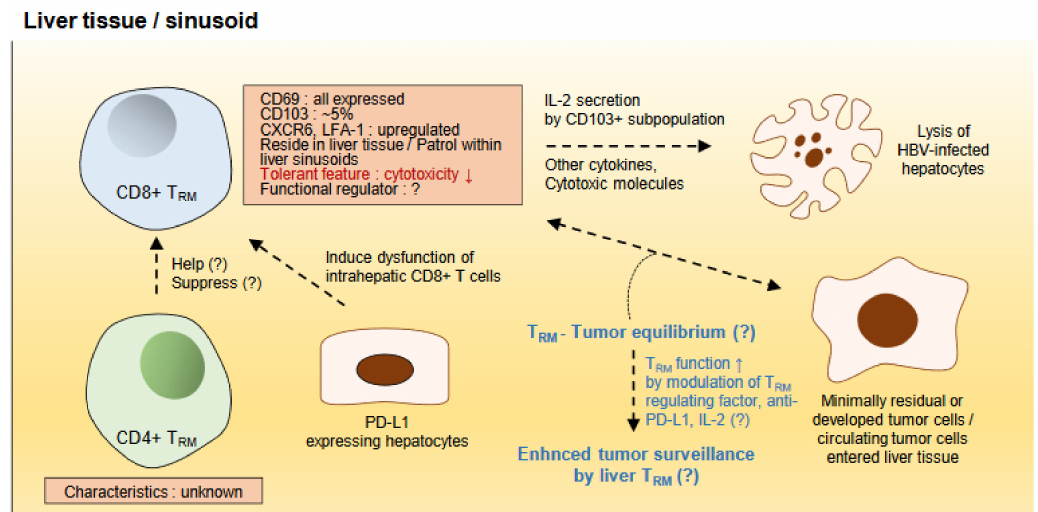
Figure 2. Suggestive model of tumor surveillance by liver T RM cells. The liver CD8+ T RM cells have been studied in several previous reports. They express CD69, but CD103 is expressed in the small portion among the CD69+ population in human. They express chemokine receptor type 6 (CXCR6) and lymphocyte function-associated antigen-1 (LFA-1) and persist in the liver tissue or liver sinusoid. Although their regulating factor is still unknown, liver CD8+ T RM cells are considered to be functionally impaired or tolerant compared with the other T cell population. This might be associated with the priming by PD-L1-expressing hepatocytes. The CD103+ subpopulation is known to perform an anti-viral function, because they can highly secrete IL-2 and other effector molecules against hepatitis B virus (HBV) peptide stimulation. However, the characteristics of CD4+ T RM cells and their role in the tumor surveillance are still unknown. T RM -tumor equilibrium (left-right arrow) has not been studied in the HCC model, but as in other cancers, liver CD8+ T RM cells might have a role in the surveillance against minimally residual tumor cells after HCC treatment, newly developed tumor cells, or circulating tumor cells that enter the liver tissue or sinusoid. This function of liver CD8+ T RM cells could be enhanced by anti-PD-L1 or IL-2 treatment according to the previous report of murine skin cancer model or modulation of regulating factors of liver CD8+ T RM cells, which needs to be elucidated in future studies. Each leftwards or rightwards arrow indicate that the one before the arrow affects the one after it. Question mark represents the hypothesis which is